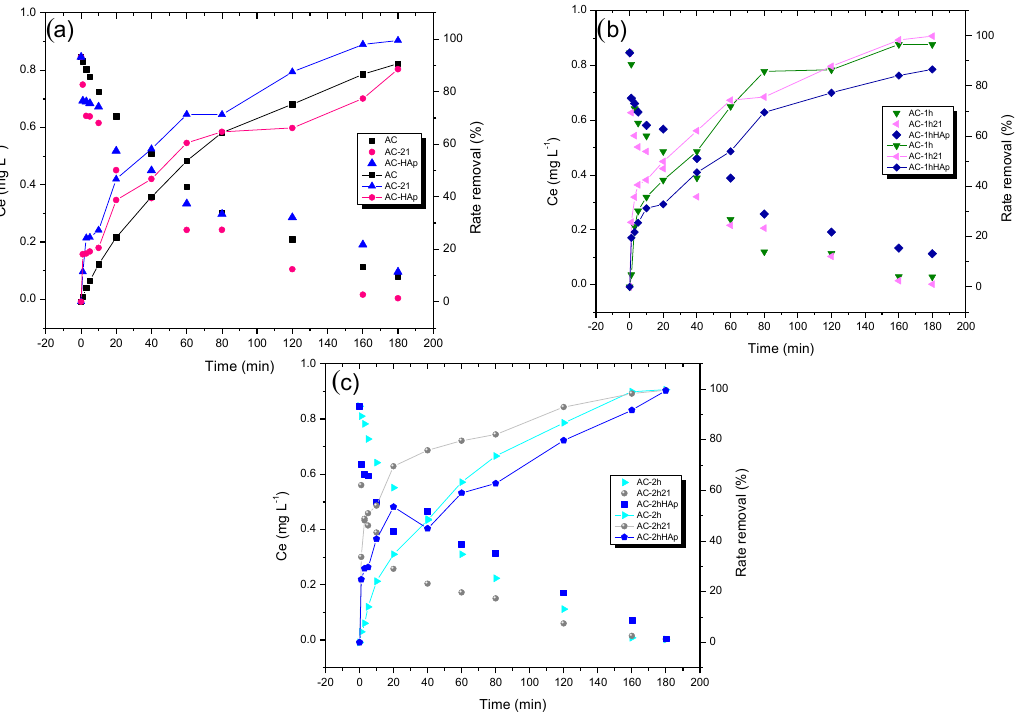
Figure 11. Effect of contact time as a function of the adsorbed concentration and removal rate of each material studied at experimental conditions of: 1 ppm, pH 7, and an initial dose of 60 mg. ( a ) Samples without oxidation, ( b ) samples with 1 h oxidation, ( c ) samples with 2 h oxidation.